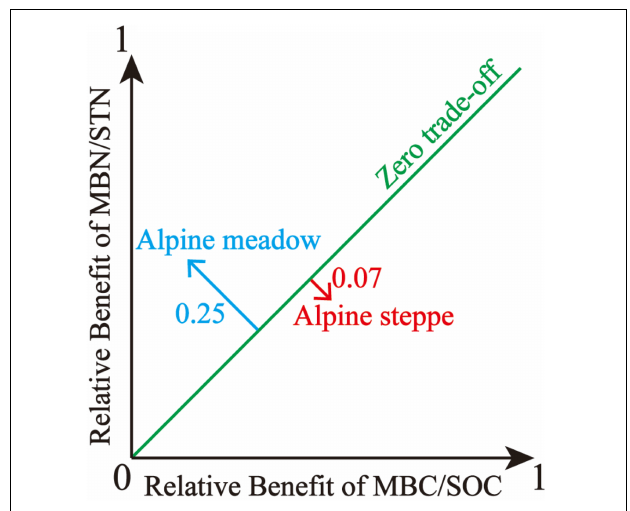
FIGURE 5 | The illustration of overall benefit between microbial entropy carbon (MBC/SOC) and microbial entropy nitrogen (MBN/STN) in alpine steppe and alpine